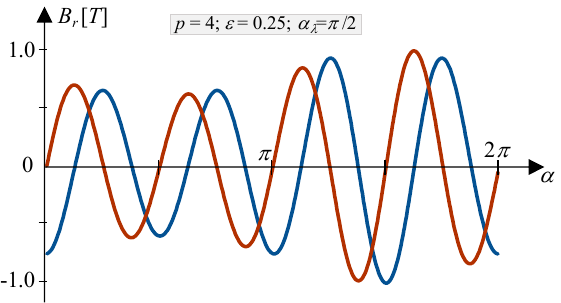
Figure 5. Sinusoidal magnetization of the magnets. Air gap flux-density due to the rotor magnets for ϑ = π / 4 (blue line) ; ϑ = π / 8 (red 1 1